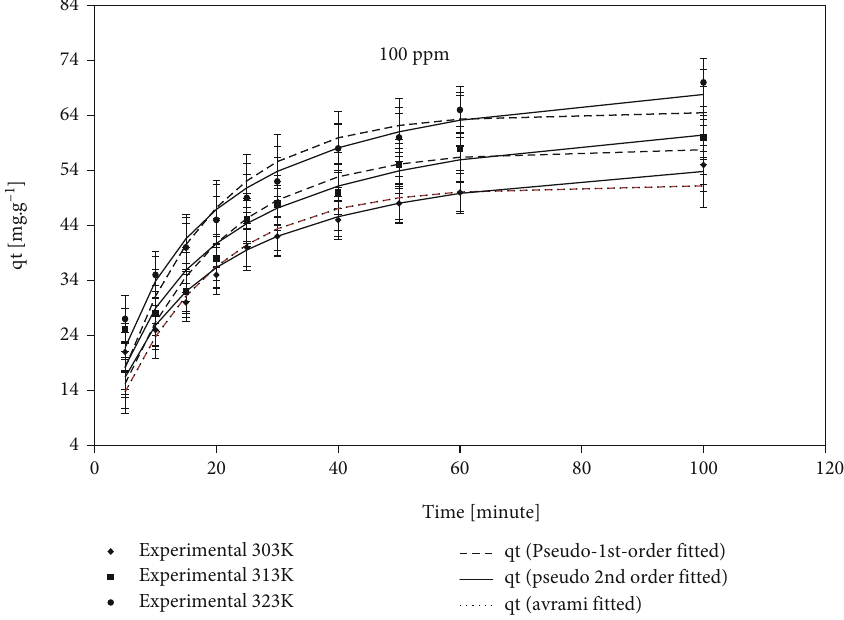
Figure 15: 100ppm CV concentration on PSS kinetic model fi t at temperatures 303 K, 313K and 323K.